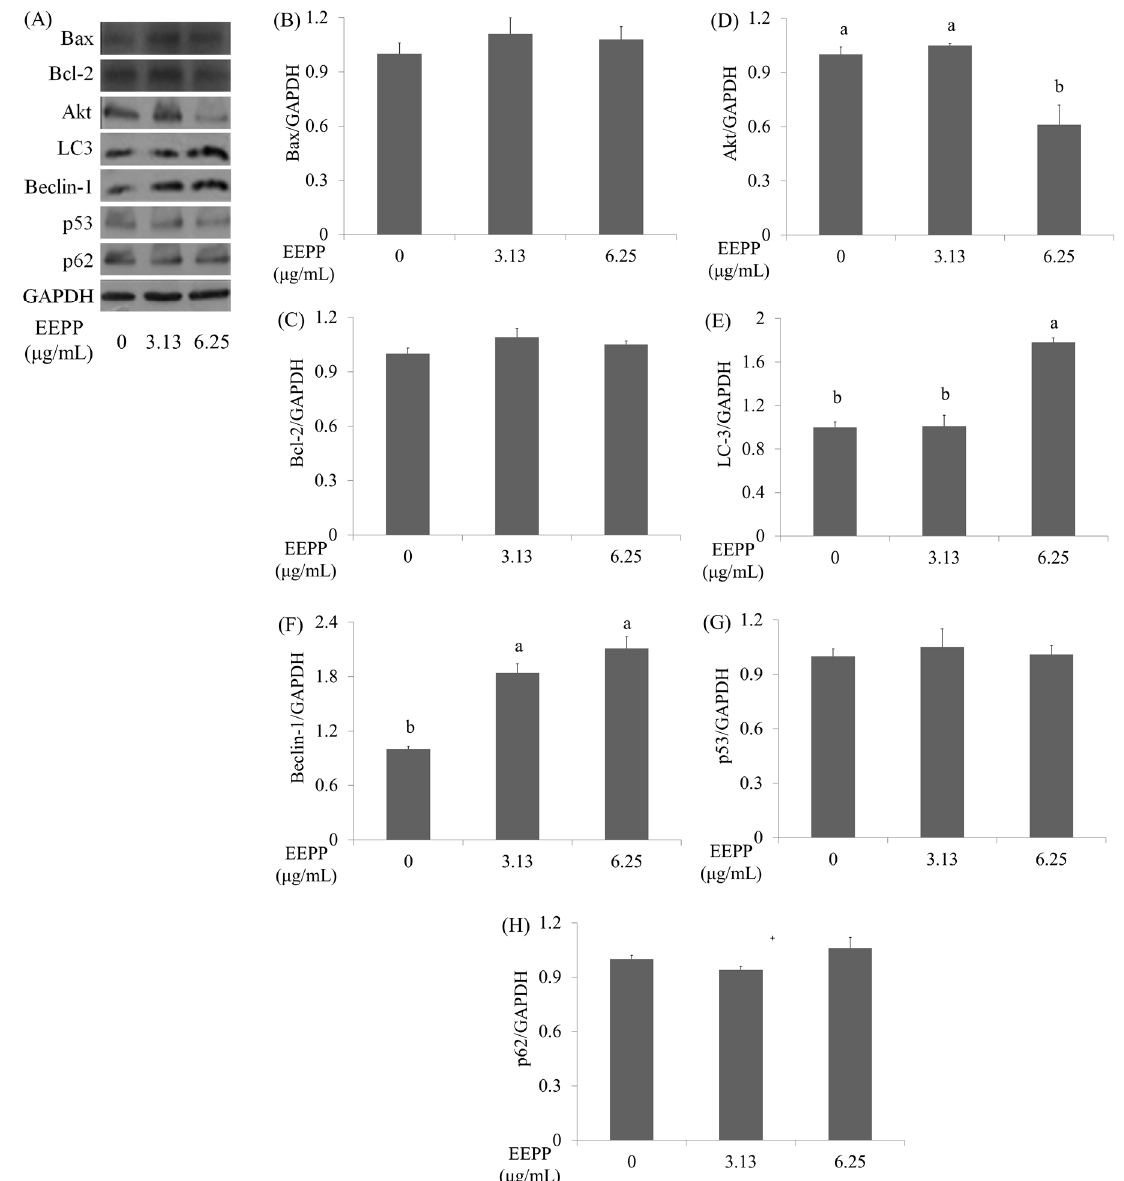
Figure 3. The effects of EEPP on apoptosis and autophagy markers. ( A ) The effects of EEPP on Bax, Bcl-2, Akt, LC-3, Beclin-1, p53, and p62 levels in DLD-1 colorectal carcinoma cells after 24 h of treatment. ( B – H ) Quantitative analysis for each protein levels. Data are shown as means ± SD ( n = 3). The significant differences are denoted by different letters ( p < 0.05).